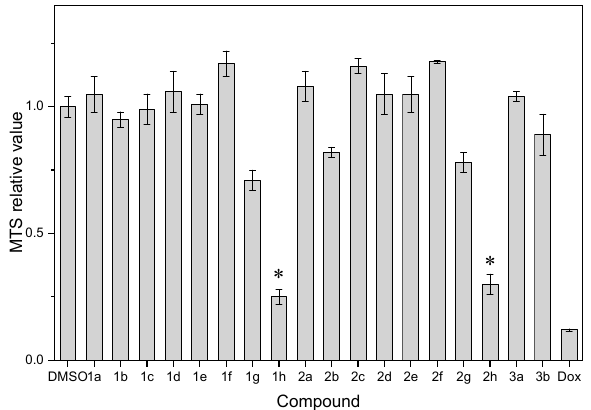
Figure 1. The MTS relative values of compounds 1 to 3 were compared with the vehicle control (DMSO) and the positive control (doxorubicin, Dox). *: compounds with MTS relative values